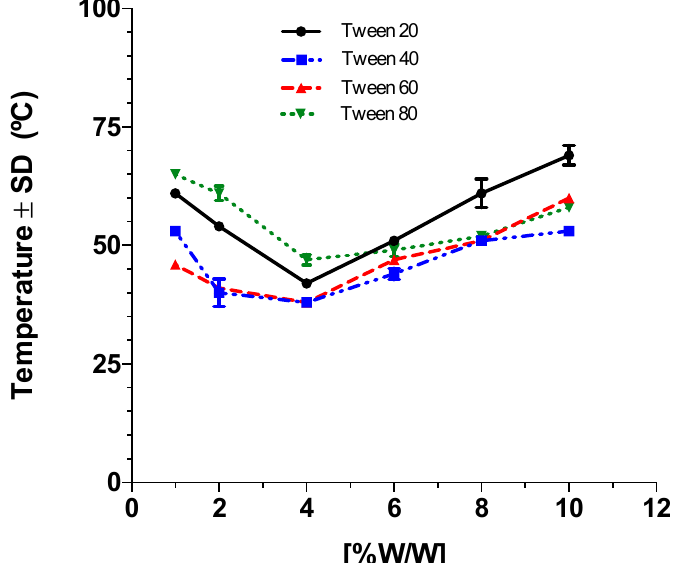
Figure 1. Determination of Cp for the different surfactants. Each point measurement was performed in triplicate.